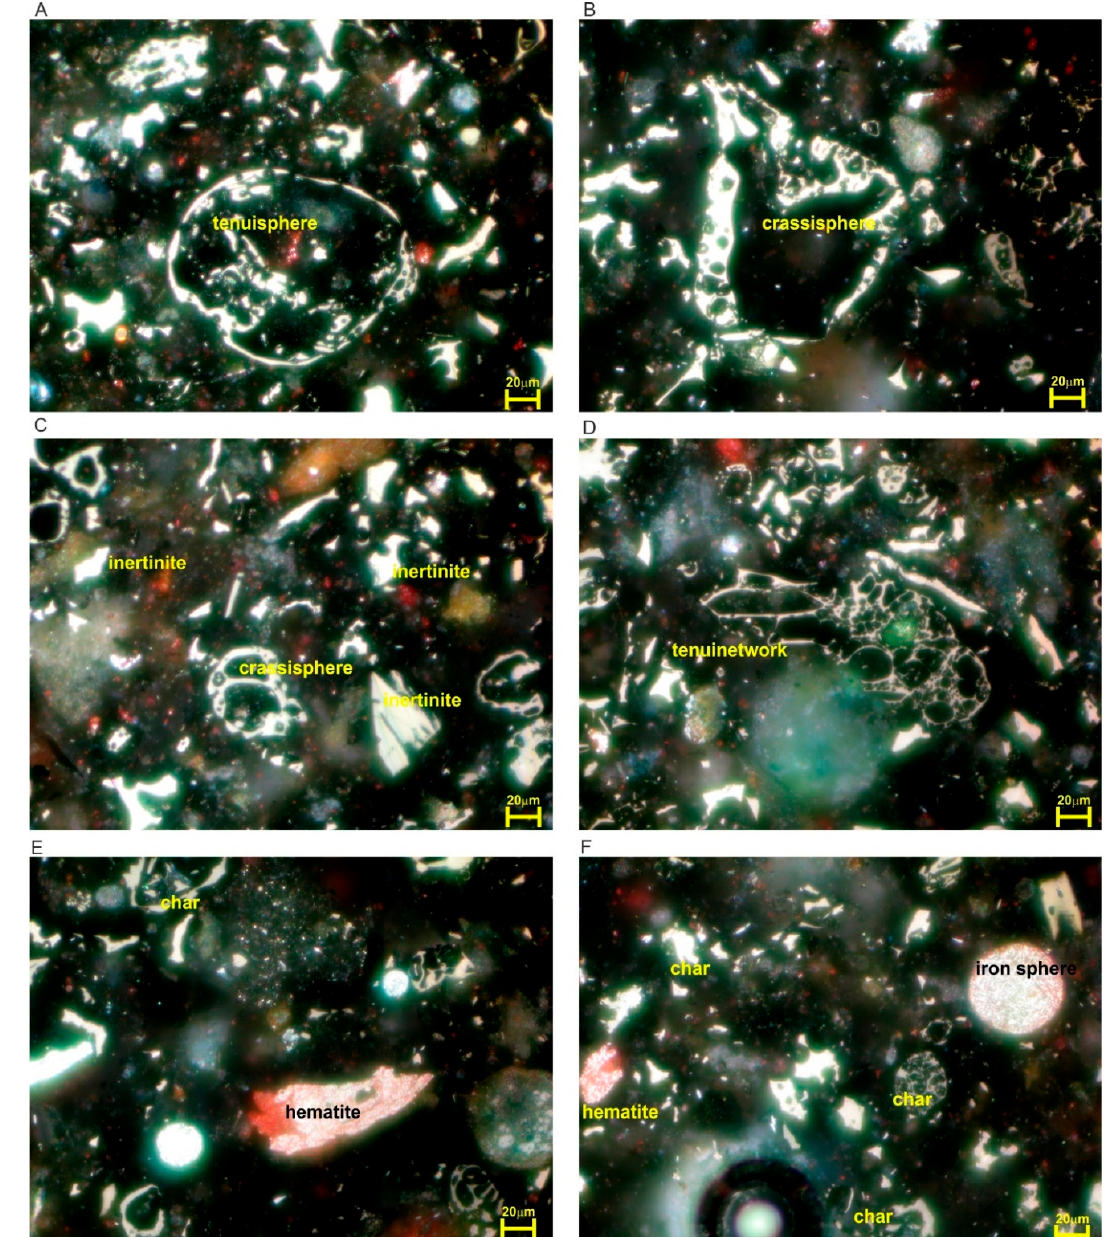
Figure 9. Microscopic image of fly ash from the combustion of gasification ash resulting from the gasification of coal from the Janina deposit: ( A ) Tenuisphere, ( B ) crassisphere, ( C ) inertinite chips and crassisphere, ( D ) tenuinetwork, ( E ) hematite and a mixture of minerals and chars, ( F ) hematite (red, left side) organic particles and an iron sphere (spherical, right side). Reflected light, oil immersion.